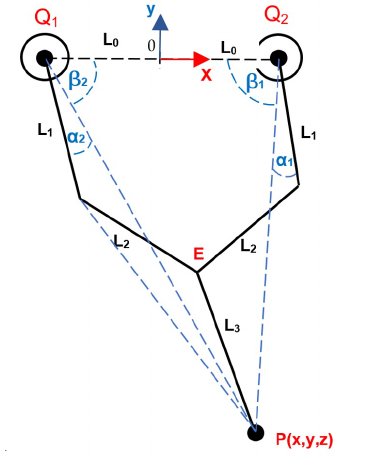
Figure 2. Kinematic diagram of the